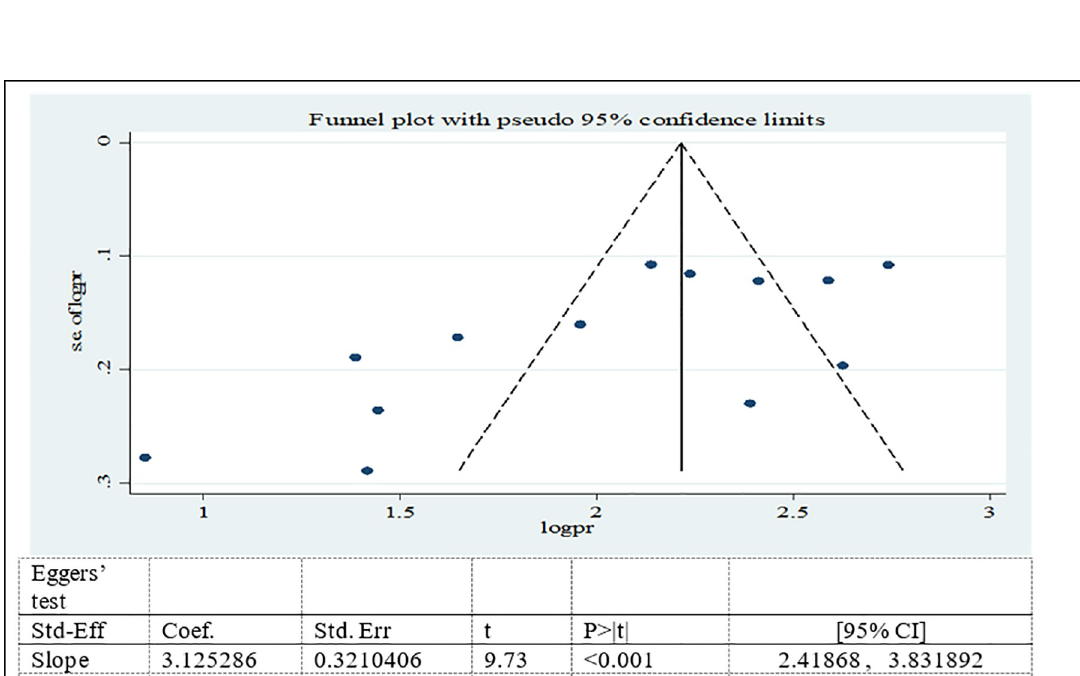
Fig 7. Funnel plot and Eggers’ test to assess publication bias for adolescent overweight/obesity in Ethiopia.